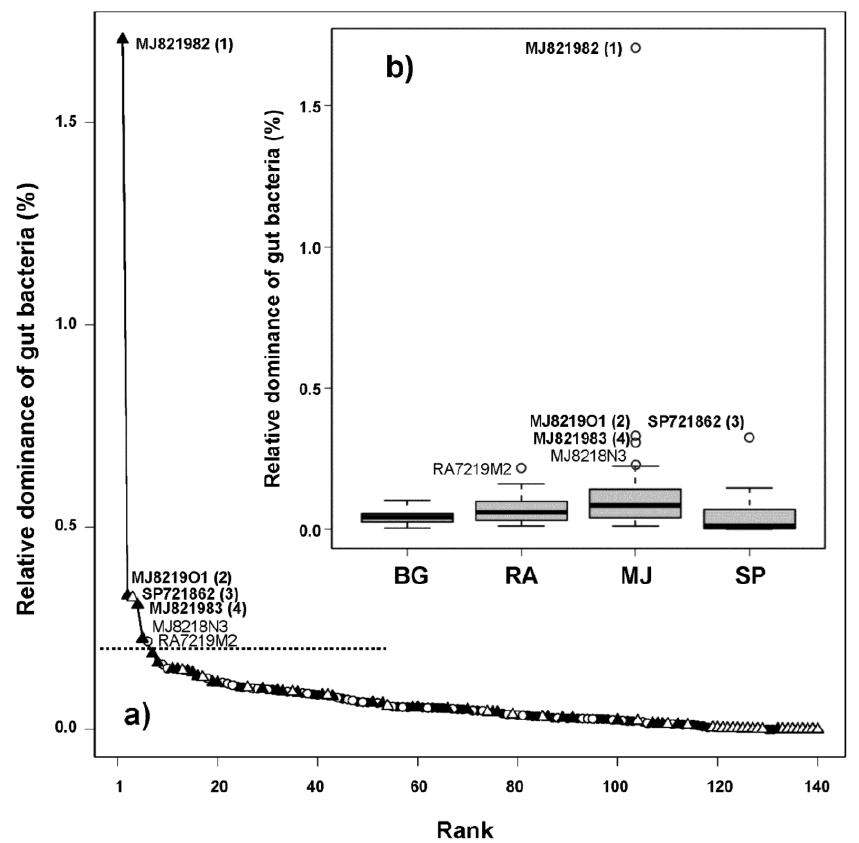
Figure 2. (a) Dominance-rank curve showing the relationship between sample rank from high (rank = 1) to low (140) and the relative dominance of gut bacteria. Closed circles, open circles, closed triangles and open triangles distinguish the vegetation/habitat types bareground (BG), Rhynchospora alba sedgeland (RA), Moliniopsis japonica grassland (MJ) and Sphagnum mat (SP). (b) box-and-whisker plots with outliers shown by circles ( n = 6) in the four vegetation types. Outliers are labelled with their sample codes, in bold if re-confirmed by Tietjen-Moore test. The detailed bacterial compositions of the first four samples (coded as 1 to 4) are explained in Table